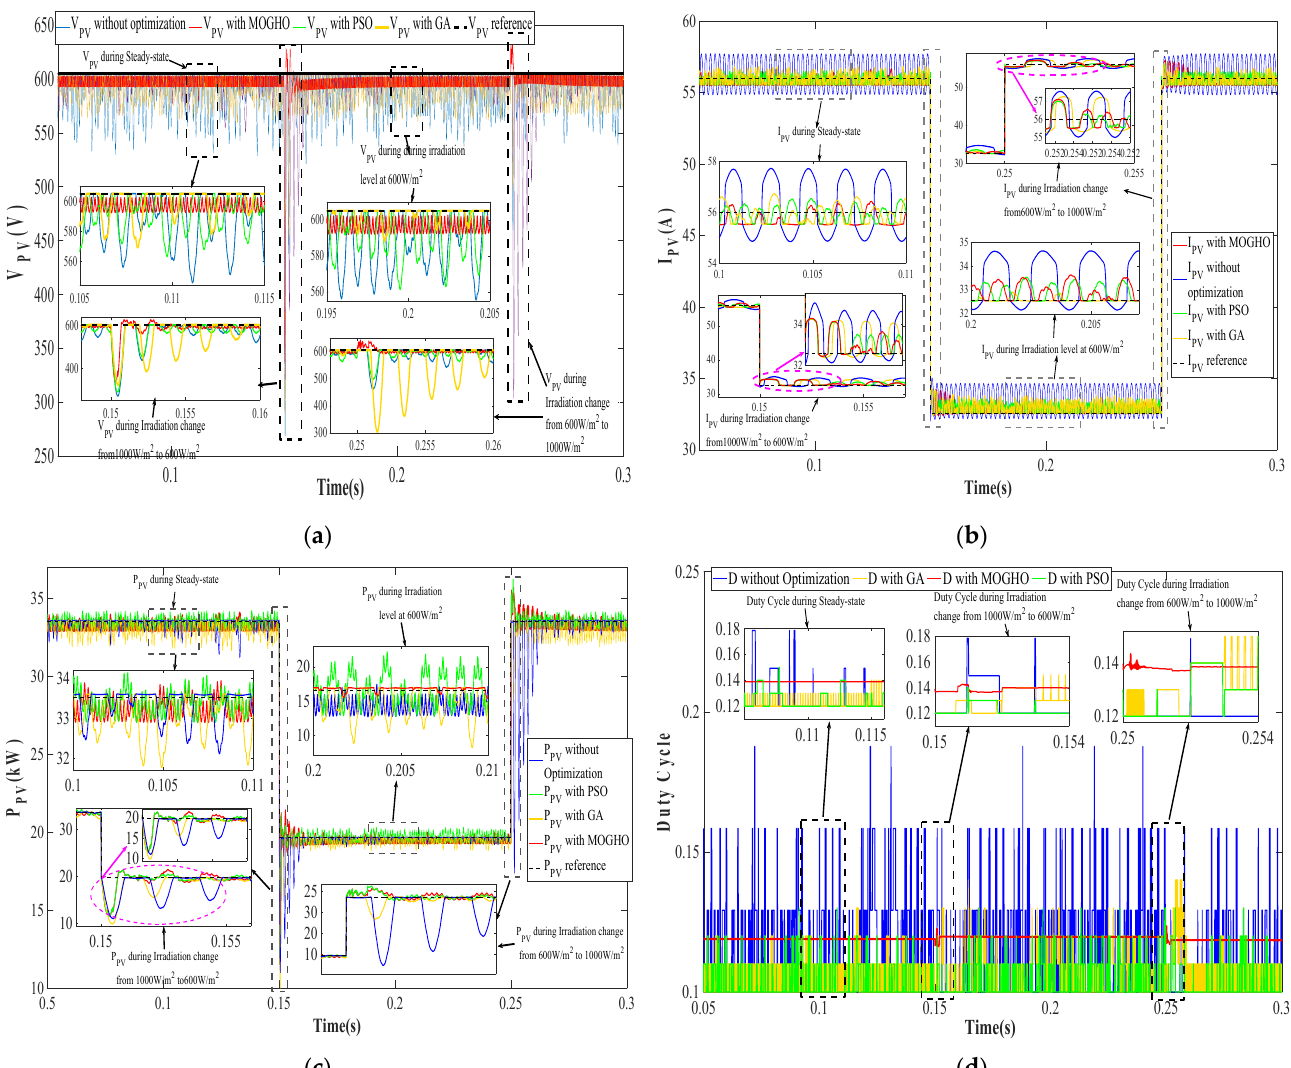
Figure 8. ( a – d ) System performance with optimized δ VSS-InC during steady-state and irradiation variation of ( a ) V PV ( b ) I PV ( c ) P PV ( d ) D.